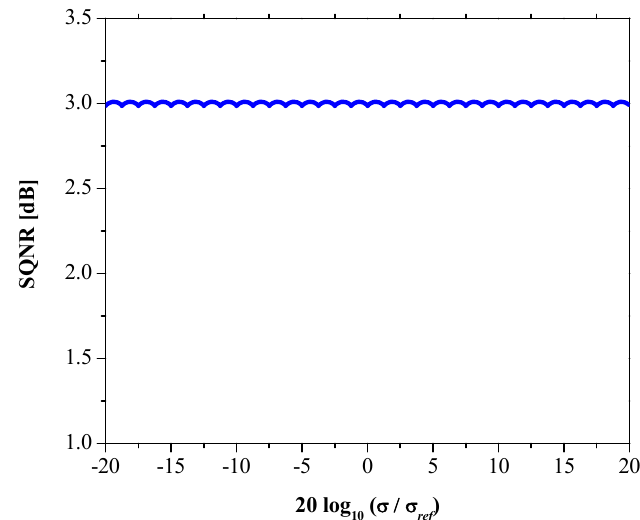
√ 2) in a wide range of input